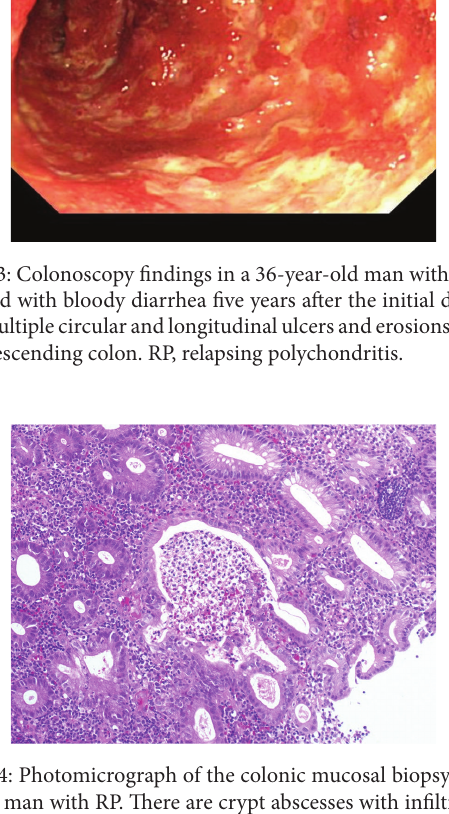
Figure 2: Photomicrograph of the nasal septum biopsy in a 36- year-old man with RP. The hyaline cartilage is eroded and infiltrated by lymphocytes, plasma cells, eosinophils, and neutrophils. (Hema- toxylin and eosin stain, × 100). RP, relapsing polychondritis.